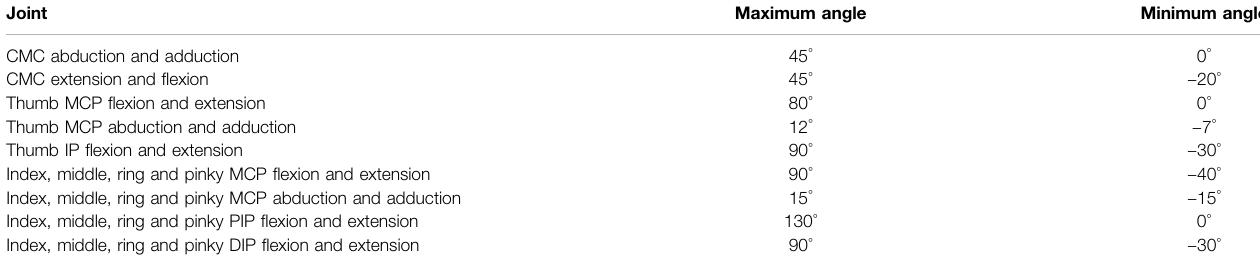
TABLE 1 | Angular bounds for each joint of the hand derived from Hochschild (2015) and Ross and Lamperti (2006).